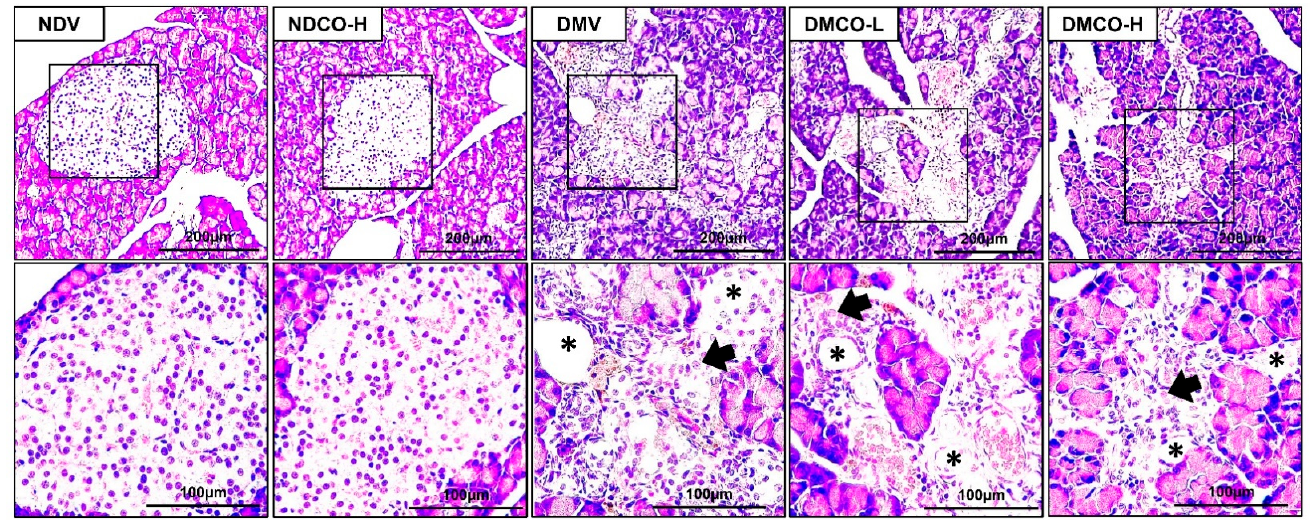
Figure 1. Effects of crocodile oil on histological appearance of pancreatic islets of Langerhans (H&E staining, 10× upper row and 40× lower row). Apoptotic cells (arrow) and vacuolization (asterisk) are observed. NDV: nondiabetic treated with vehicle; NDCO-H: nondiabetic treated with high-dose crocodile oil; DMV: diabetic treated with vehicle; DMCO-L: diabetic treated with low-dose crocodile oil; and DMCO-H: diabetic treated with high-dose crocodile oil.